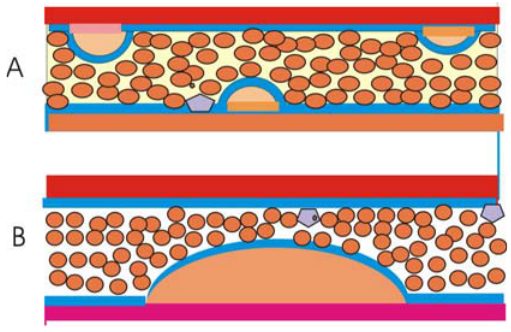
FIGURE 8 . Some variants of specific patched formations (atherosclerotic plaques) on the innermost of arterial